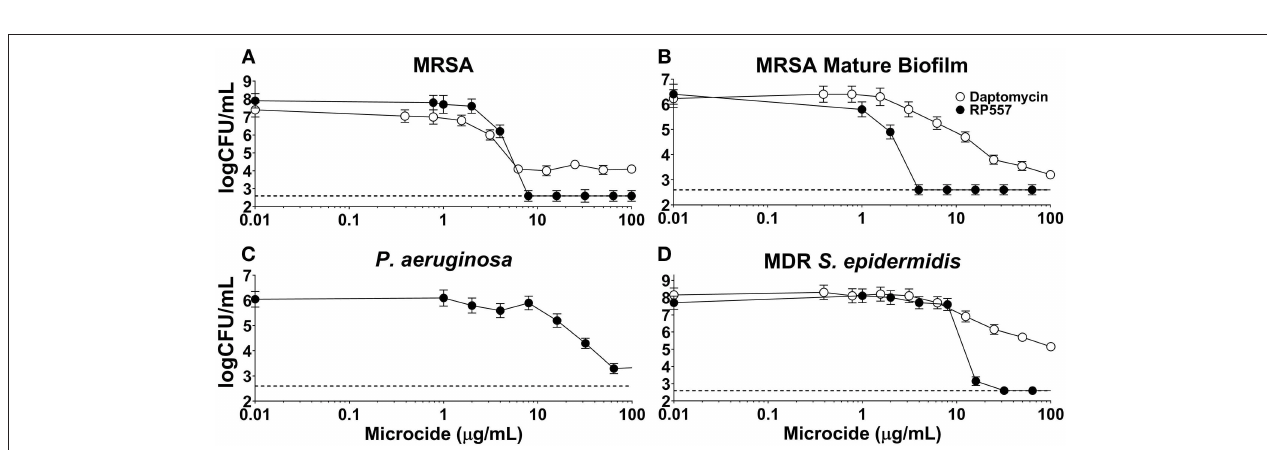
FIGURE 6 | P. aeruginosa and S. aureus did not develop resistance to RP557. Sub-inhibitory concentrations of RP557, gentamicin and clindamycin were cultured with P. aeruginosa ATCC 27853 (A) and S. aureus ATCC 29213 (B) for 24h. Bacteria showing growth in the highest concentration were re-passaged in fresh dilutions containing sub-MIC levels of each component for 30 consecutive passages; means are shown.